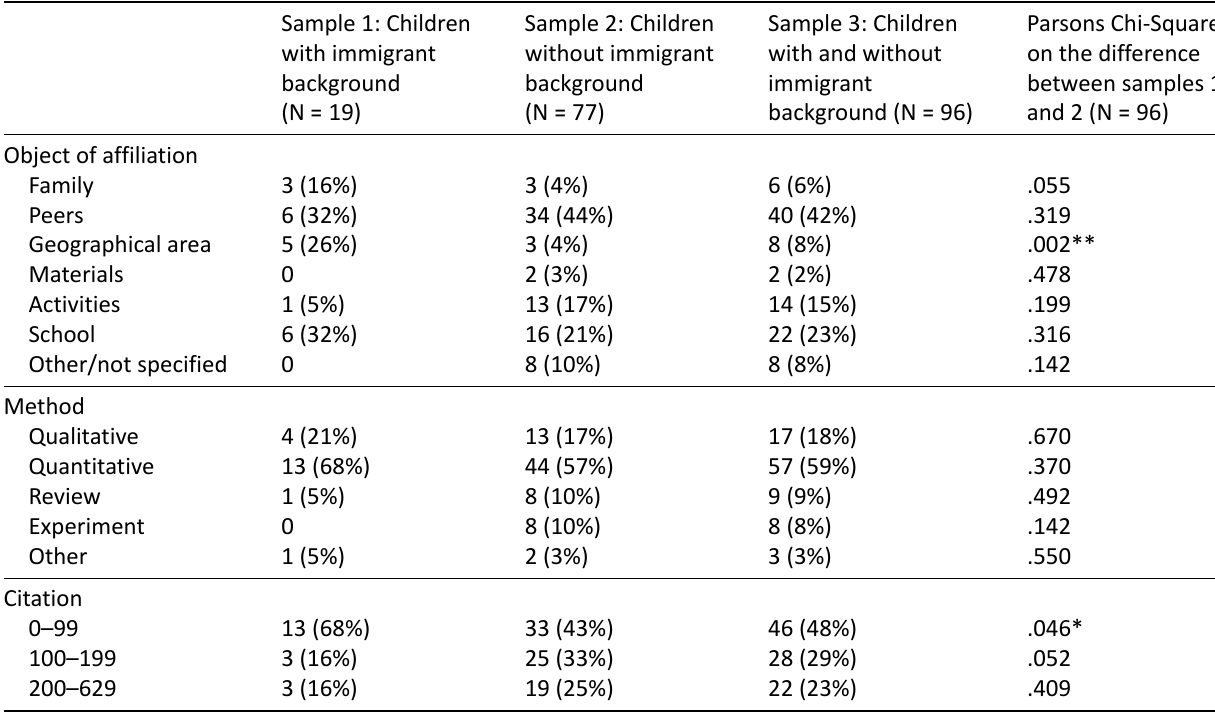
Table 3. (Cont.) Number of articles on children’s connections (samples 1, 2, and